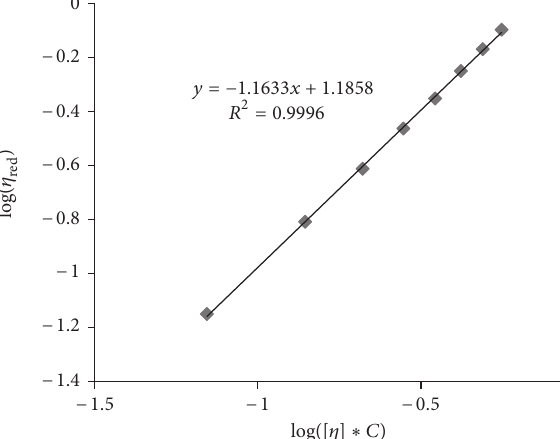
F 9: FTIR of FP gum.